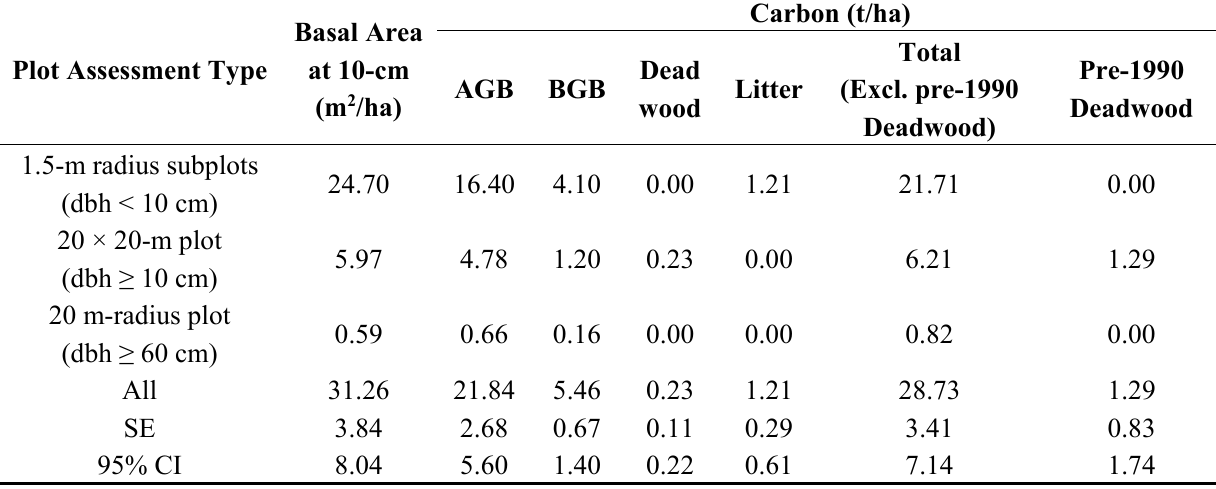
Table 4. Mean basal area 10-cm above ground level and mean carbon stocks by pool in 2012 (t C/ha), including pre-1990 deadwood by plot assessment type and sum across all types. Note that post-1989 deadwood includes litter attached to stems with a basal diameter ≥ 10 cm, whereas the litter pool includes litter attached to stems with a basal diameter < 10 cm. Basal Area Plot Assessment Type at 10-cm wood